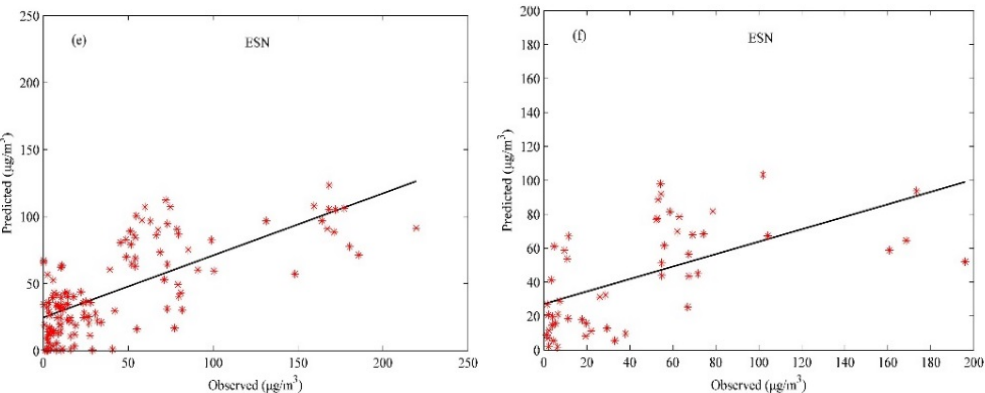
Figure 7. Scatter plots between the observed and the predicted PM 2.5 concentrations for models: ( a ) SOG-SASOFNN for training set; ( b ) SOG-SASOFNN for test set; ( c ) FOG-SASOFNN for training set; ( d ) FOG-SASOFNN for test set; ( e ) ESN for training set; and ( f ) ESN for test set.